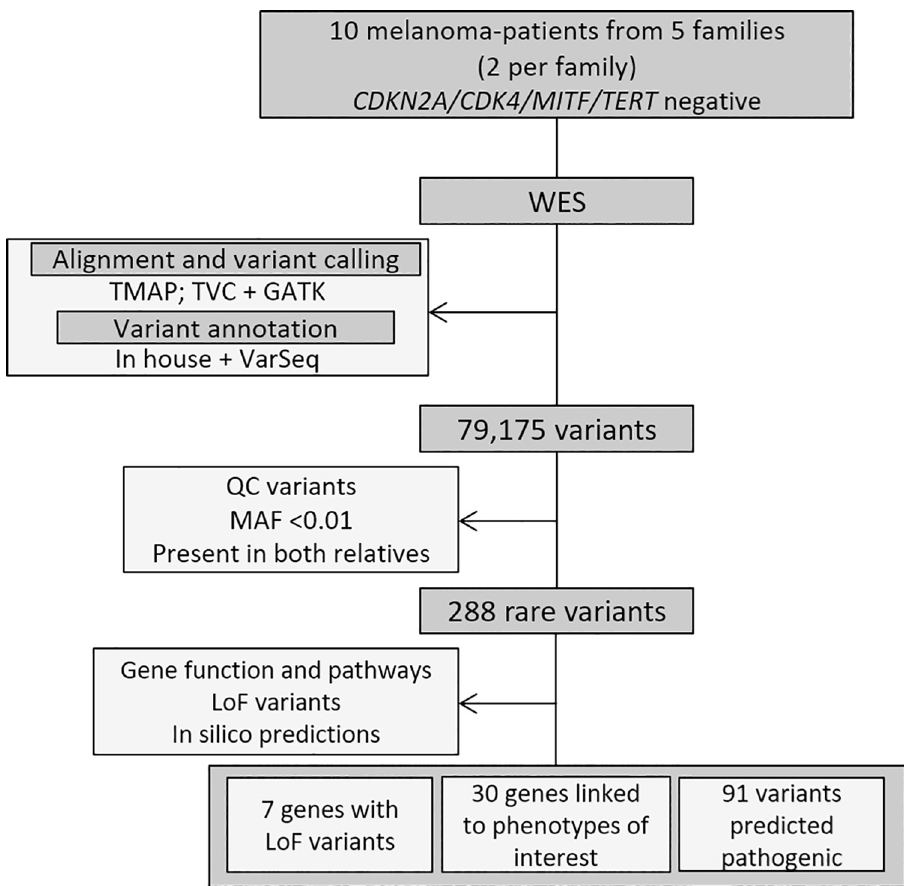
Fig 2. Diagram of the germline sequencing analysis and variant prioritization strategy, showing the main technical processes. WES data from 10 melanoma patients were analyzed using quality and frequency-based filters, resulting in 288 rare non-synonymous variants identified in both affected members of each family, which were investigated further for their predicted pathogenicity and gene function. WES, whole exome sequencing. TMAP, Torrent Mapper; TVC, Torrent Variant Caller; GATK, Genomic Analysis Toolkit; QC, Quality Control; MAF, minor allele frequency; LoF, Loss of